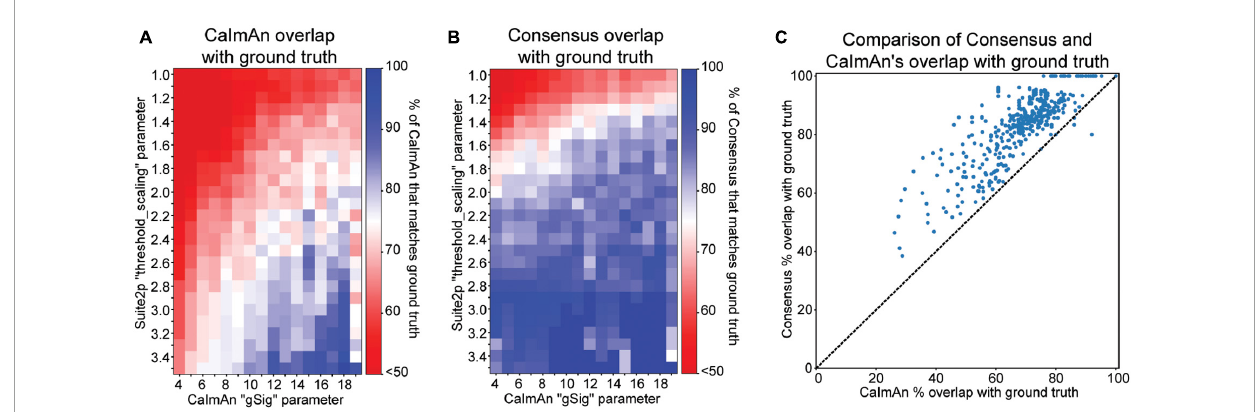
FIGURE4 Cell detection comparisons to ground truth data. (A) Proportion of CaImAn’s detected cells that overlap with ground truth cell locations at a range of parameter configurations. (B) Proportion of consensus analysis (Suite2p and CaImAn) cell locations that overlap with ground truth cell locations at a range of parameter configurations. (C) Scatter plot of each pixel value in panels plots (A,B) , comparing the percentage overlap with ground truth from CaImAn alone to that of CaImAn’s consensus with Suite2p.